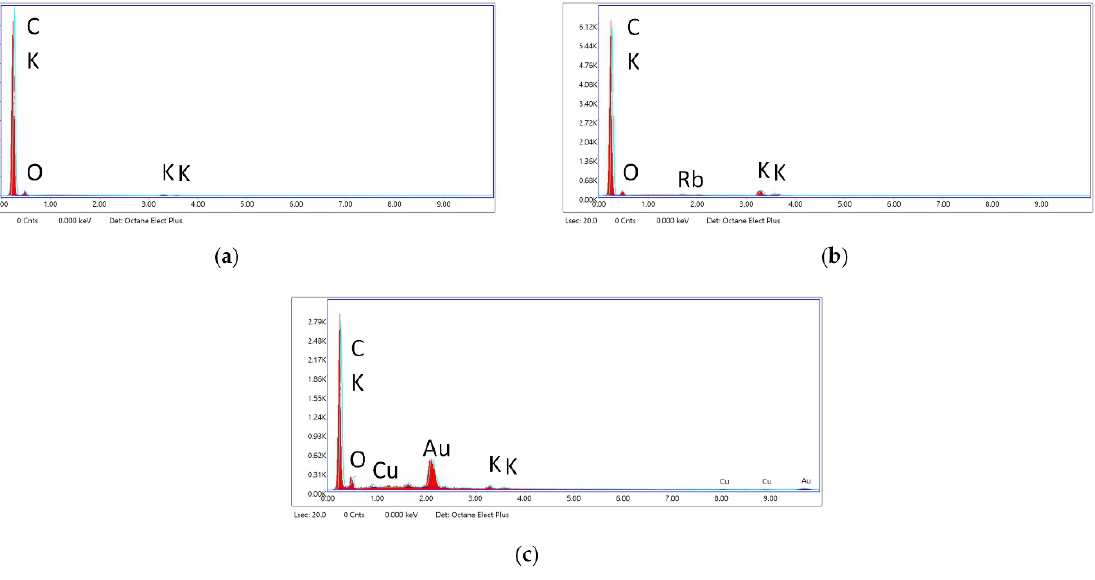
Table 6. EDS analysis of the three carbon-based sorbents (elements in weight % 1 ). C